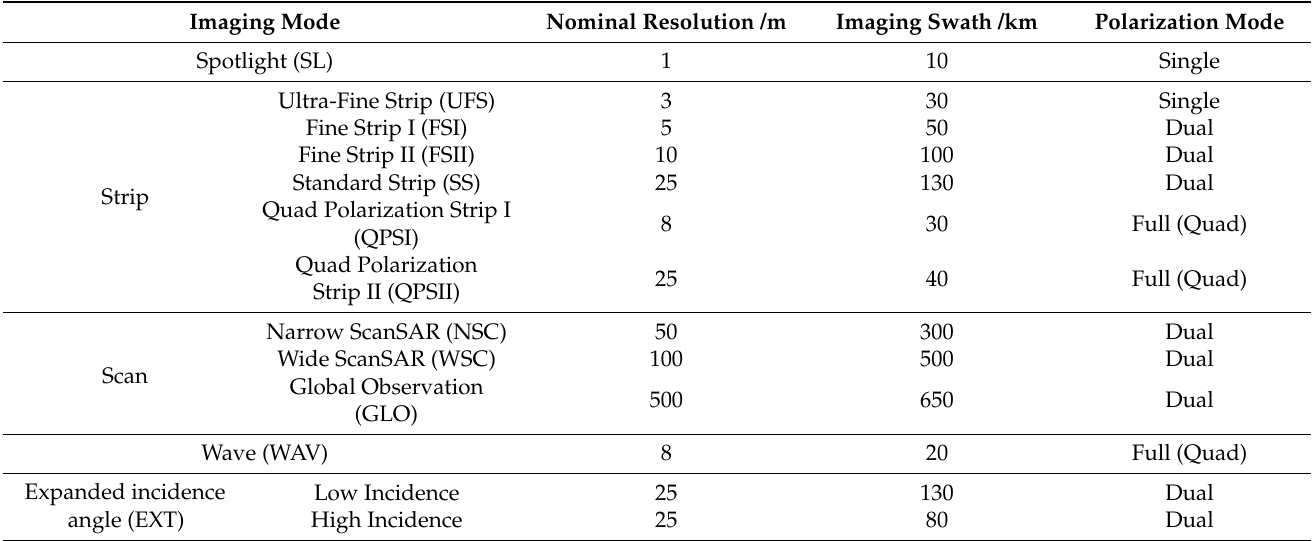
Table 1. C-SAR/01 imaging mode.